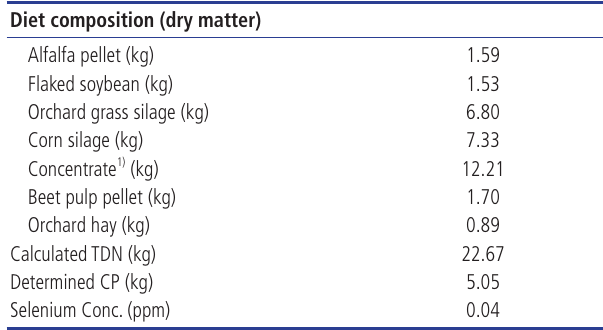
Table 1. Representative composition of TMR (body weight 696 kg, milk production 49.2 kg, 60 days after delivery, Parity 2) Diet composition (dry